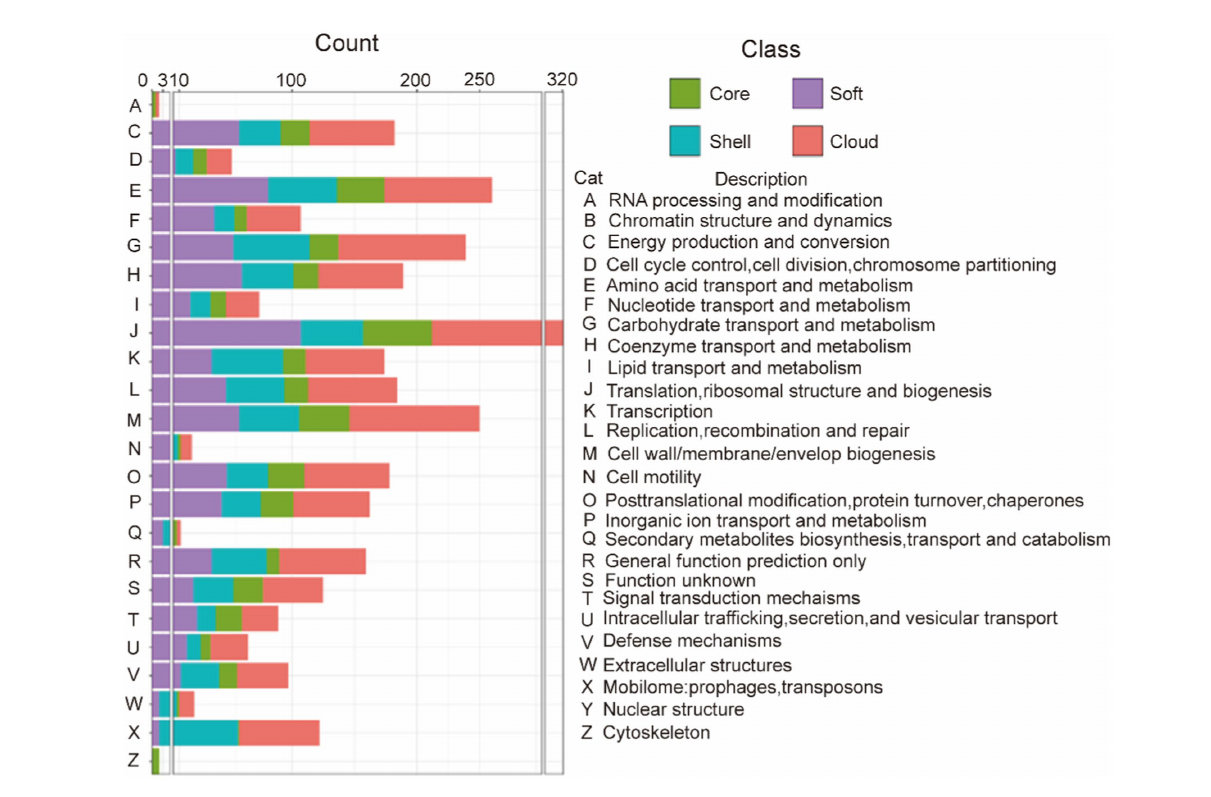
FIGURE 1 COG annotation of the core genome and the accessory genome. The category is shown in Table 2, green represents the core gene, purple represents the soft-core gene, blue represents the shell gene, and red represents cloud